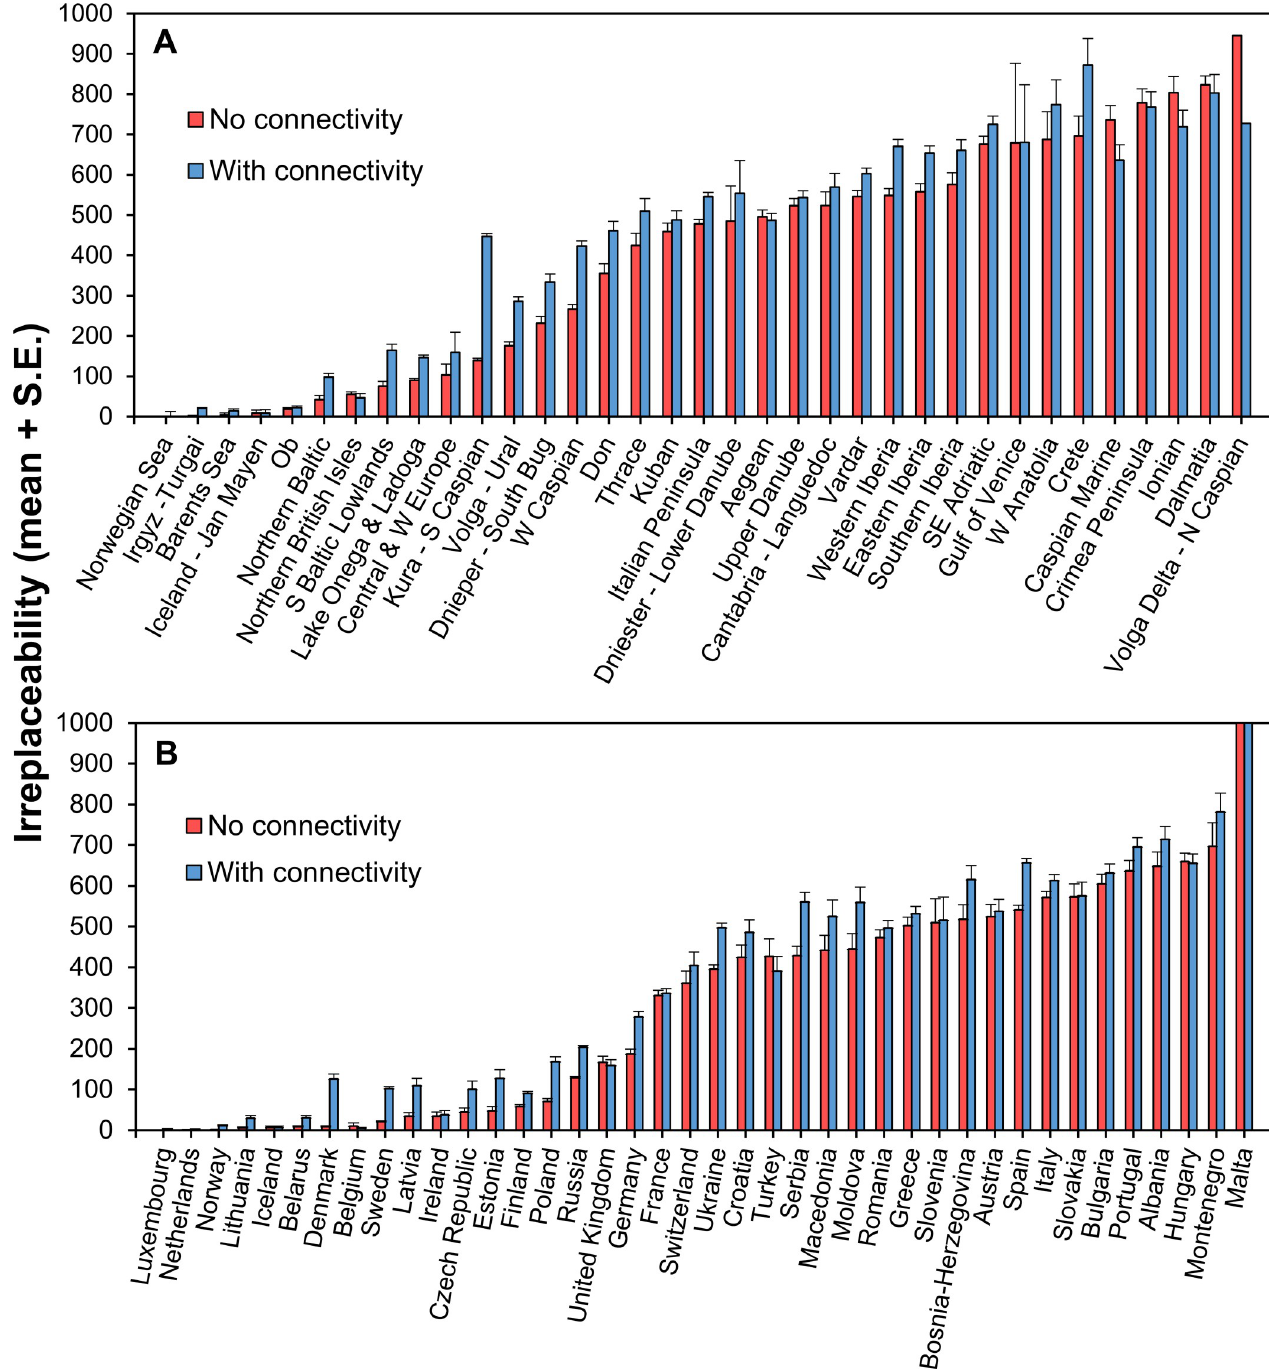
Fig 2. Mean ± SE irreplaceability (selection frequency) of freshwater ecoregions (A) and countries (B) of